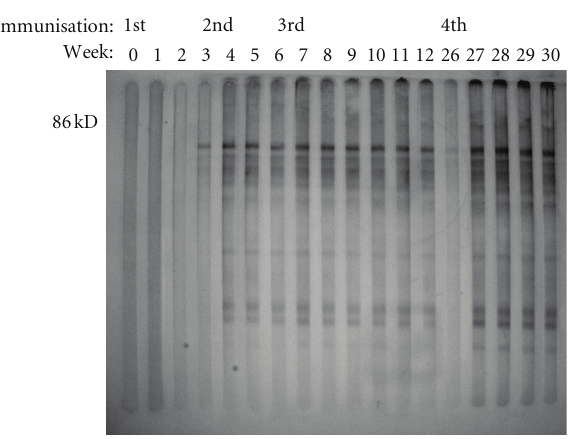
Figure 2: Multiscreen Western blot of sera from one Bm91- immunized animal using the Bm91 antigen